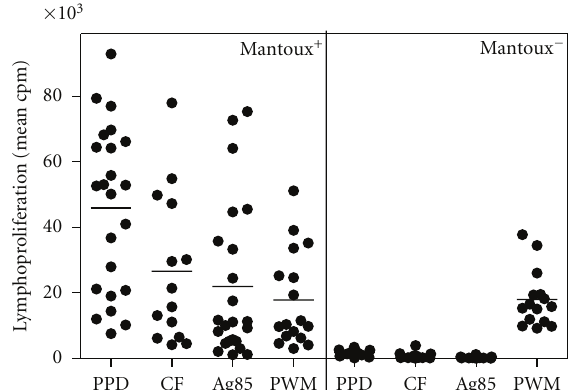
Figure 1: Proliferative responses (mean cpm) in response to PPD, CF from BCG, purified Ag85, and Pokeweed Mitogen in healthy tuberculin-positive ( n = 23) and tuberculin-negative HIV-negative ( n = 15) volunteers, as measured after 7 days of culture, using a whole blood assay (heparinized blood diluted 1: